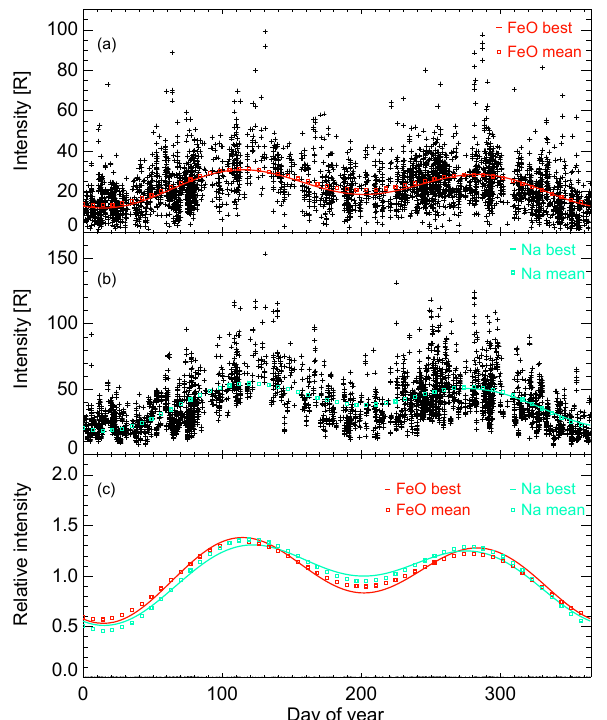
Figure 5. Harmonic analysis: this figure shows the results of the harmonic analysis of FeO in (a) and Na in (b) . The best-fit approach is plotted with a solid line, while the squares indicate the Bayesian (mean) solution. The coefficients of the best fit and mean are given in Table 1. (c) Compares the behaviour of FeO and Na relative to their annual mean. The colours, lines and symbols are the same as in the panels